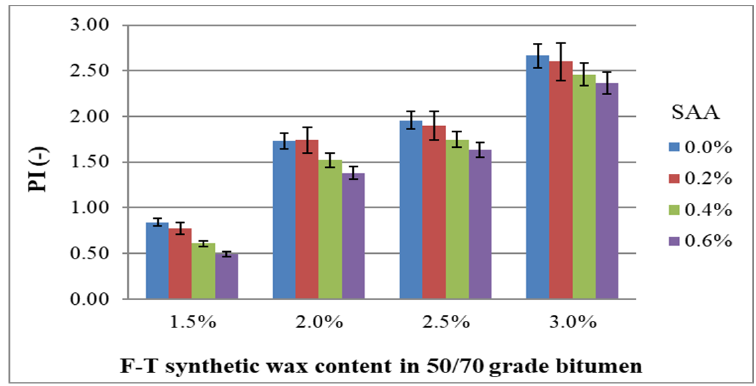
Figure 14. Relationship between the penetration index of bitumen 50/70 and the contents of F–T wax